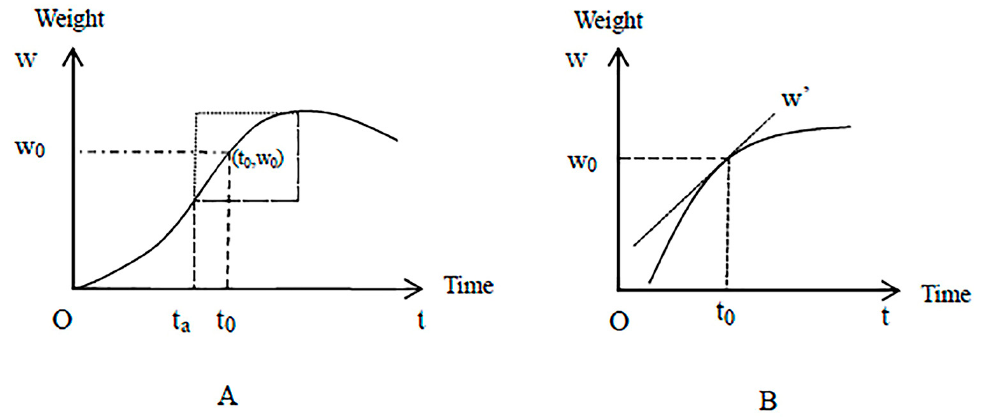
Figure 2. The graph of pig weight versus breeding time. ( A ) The graph of pig weight versus breeding time. ( B ) The graph of the relationship between breeding time (after t a ) and pig weight. Breeding time is denoted by “t” and “w” denotes pig weight. t a denotes the point when the marginal weight gain of pigs reaches its maximum; t 0 denotes the point at which farmers slaughter the pigs to maximize profit without the influence of external shocks.